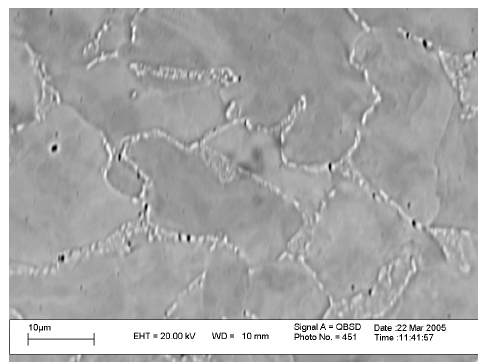
Figure 14: Voids present at grain boundary. Figure 15: Void coalescence in front of